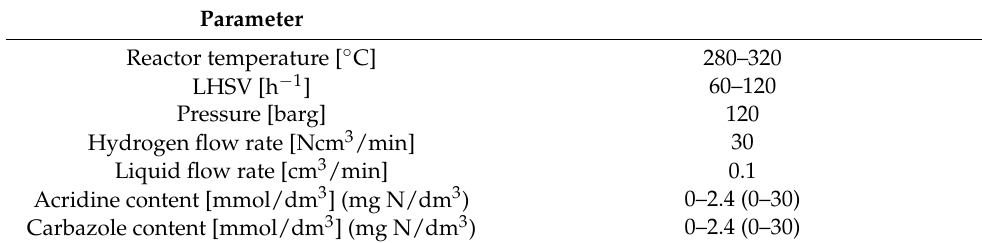
Table 3. Experimental conditions used in this